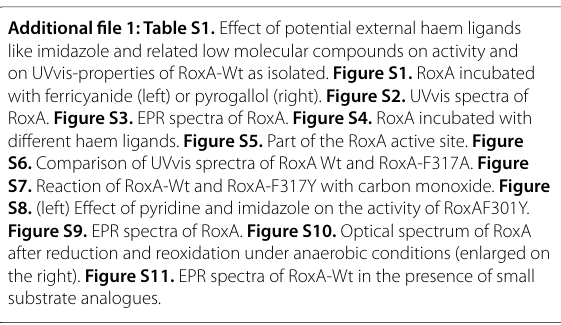
RoxA. Figure S3. EPR spectra of RoxA. Figure S4. RoxA incubated with different haem ligands. Figure S5. Part of the RoxA active site. Figure S6. Comparison of UVvis sprectra of RoxA Wt and RoxA-F317A. Figure S7. Reaction of RoxA-Wt and RoxA-F317Y with carbon monoxide. Figure S8. (left) Effect of pyridine and imidazole on the activity of RoxAF301Y. Figure S9. EPR spectra of RoxA. Figure S10. Optical spectrum of RoxA after reduction and reoxidation under anaerobic conditions (enlarged on the right). Figure S11. EPR spectra of RoxA-Wt in the presence of small substrate